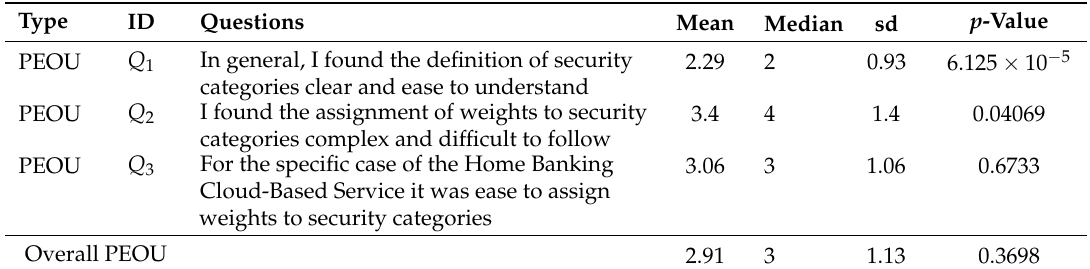
Table 11. Scoring of Categories Questionnaire—Descriptive